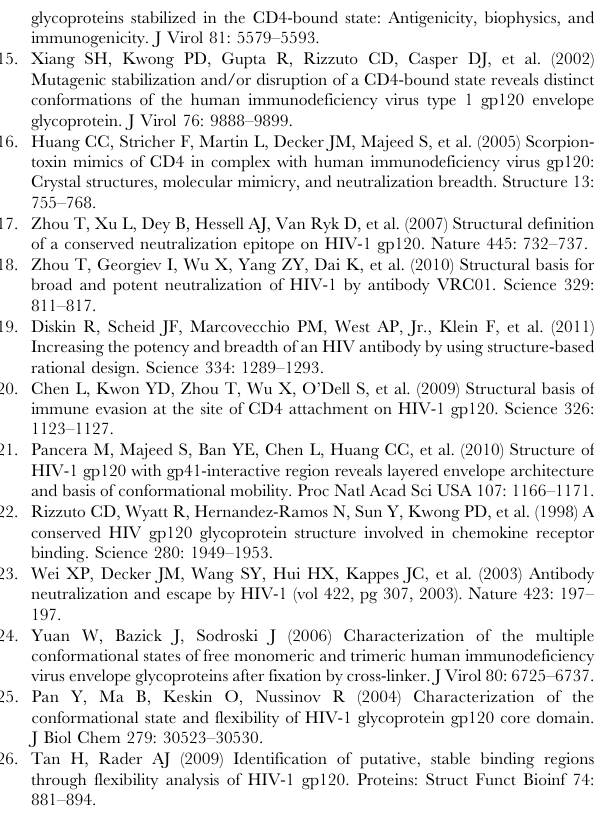
isolated state. The atomic fluctuations are calculated using full atomic NMA in a solvent shell (see main text). Fluctuations of gp120 in (A) mode 1, ( B) mode 2, (C) mode 3, (D) mode 4. View as ‘‘slide show’’ to visualize fluctuation animations. Figure S2 Structural plasticity of gp120 around the CD4-bound state. The atomic fluctuations are calculated using full atomic NMA in a solvent shell (see main text). Computation is